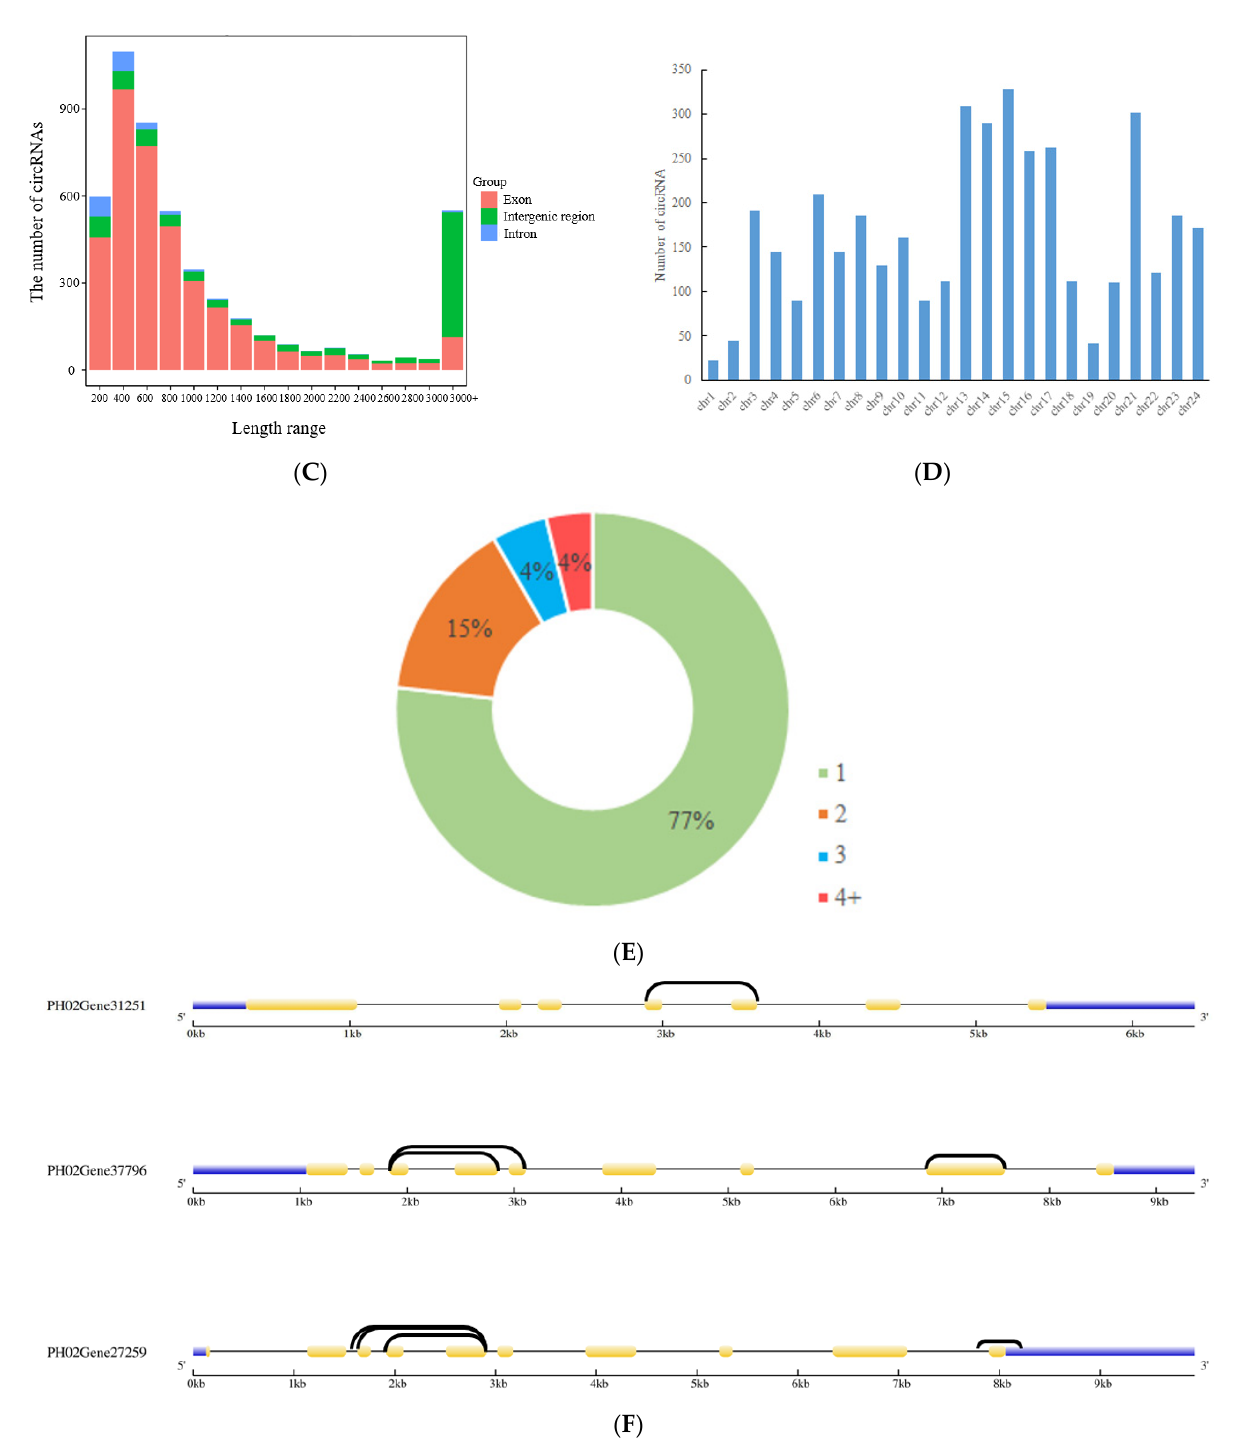
Figure 1. Genome-wide analysis of circRNAs in moso bamboo under the drought stress treatment. ( A ) Venn diagram indicates the number and distribution of circRNAs detected in five periods. ( B ) Accumulative bar diagram shows the types of circRNAs in each sample. ( C ) Length range of moso bamboo circRNAs in three groups. ( D ) Histogram shows the number of circRNAs detected in each chromosome. ( E ) Percentage of circRNAs produced from the same host gene. ( F ) Examples of three host genes that produce different numbers of circRNAs.